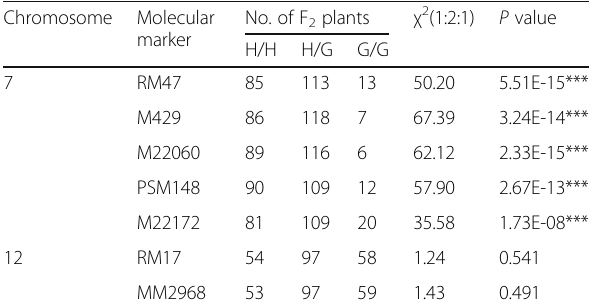
Table 1 Segregation analysis of the F 2 families derived from crossing NIL7 with HJX74 Table 2 Pollen and spikelet fertility of the parents and F